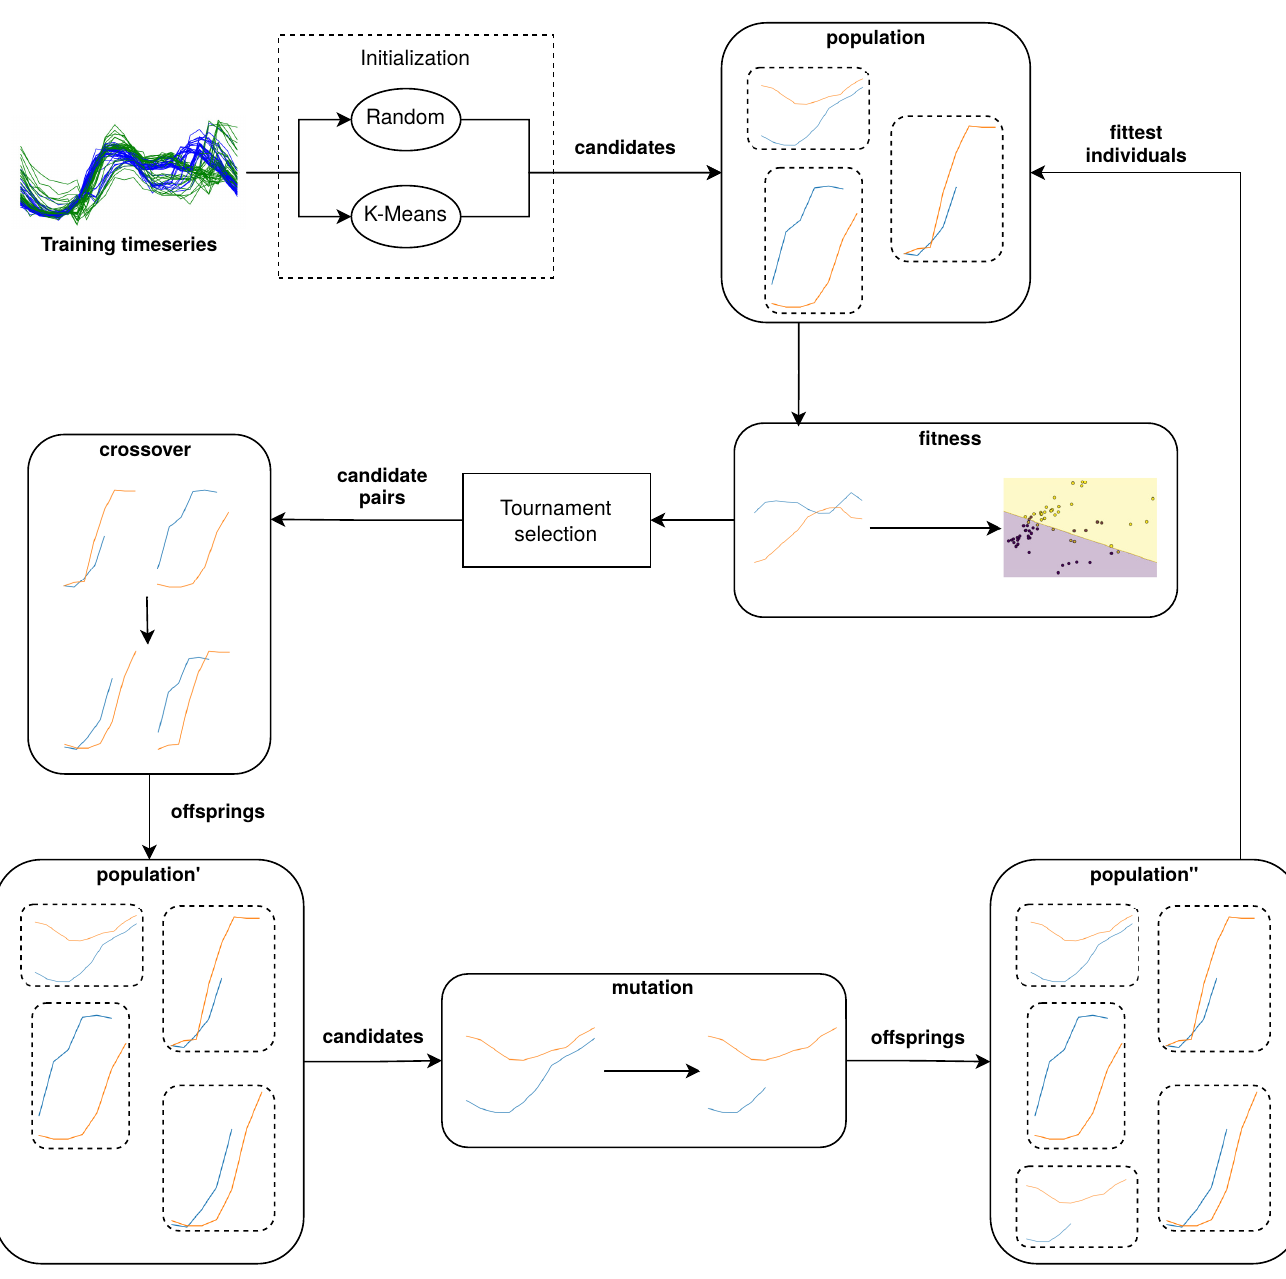
Figure 2. A conceptual overview of GENetic DIscovery of Shapelets ( gendis